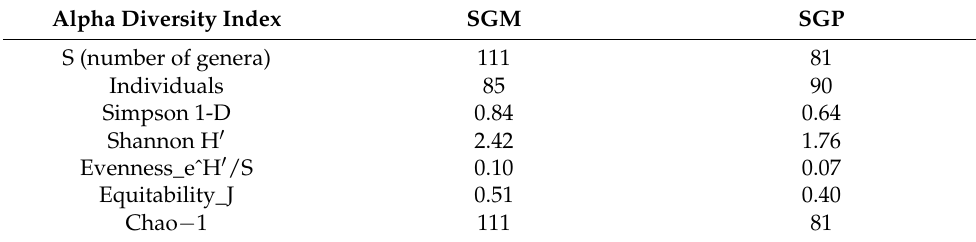
Table 2. Alpha diversity in soil